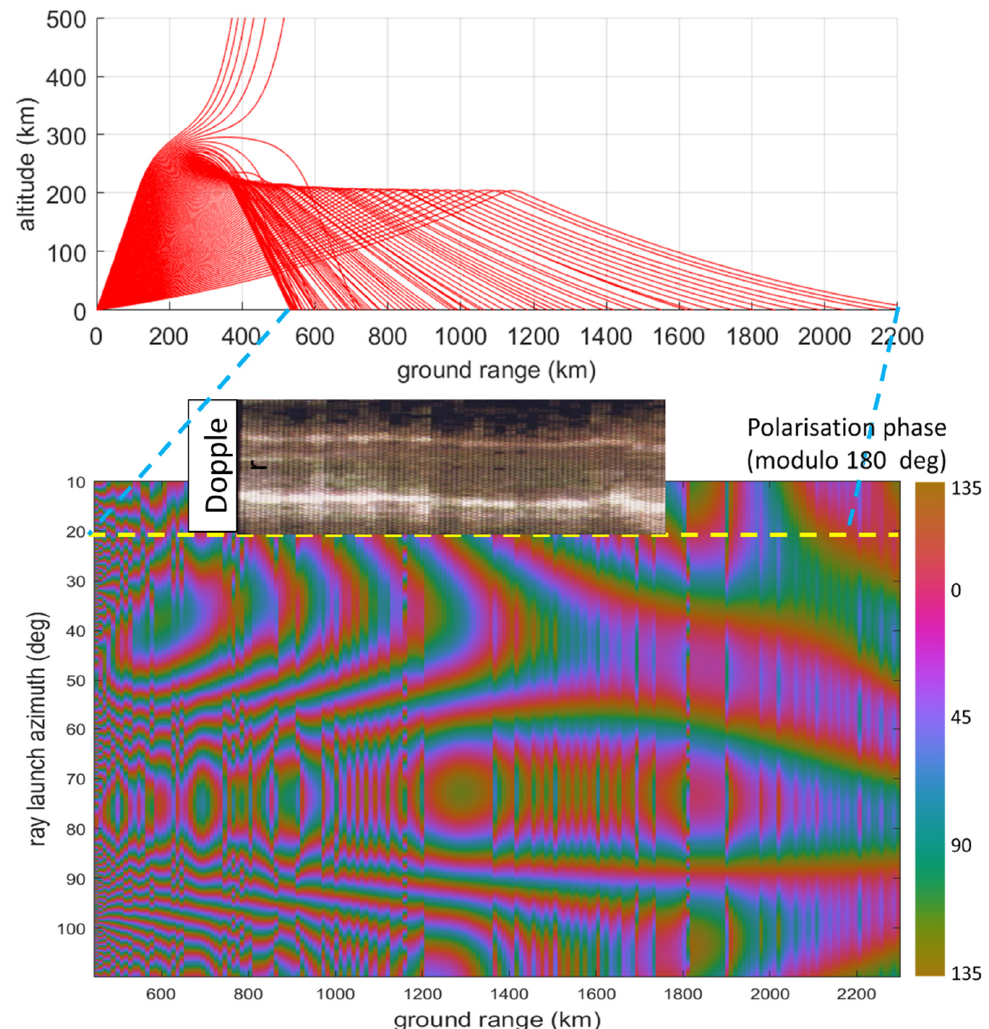
Figure 15. The main figure shows the polarisation map predicted for a particular radar, frequency, and ionospheric environment, with the polarisation phase (angle of the principal axis of the electric field) shown in colour using a cyclic colour scale. Experimental data showing a quasi-periodic intensity modulation of the sea clutter, presented in grey-scale, is overlaid at the single azimuth at which it was measured; the modelled ray fan for that azimuth is plotted at the top [46]. The peaks in clutter intensity align with occurrences of the vertically-polarised incident field.